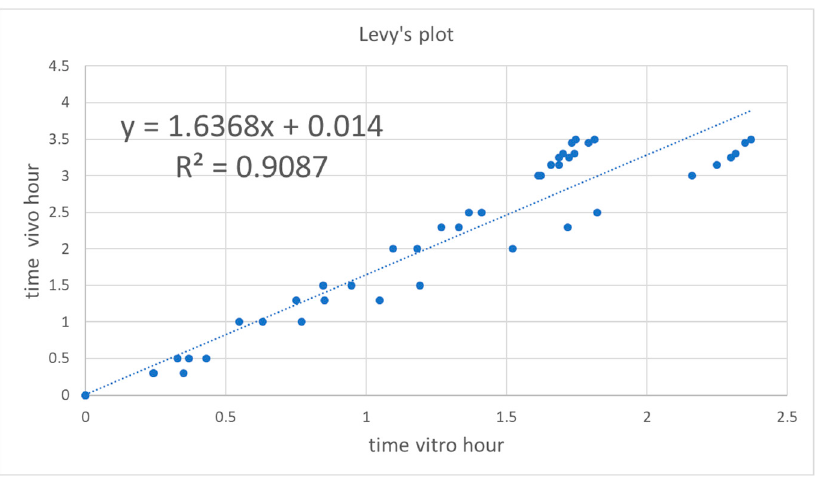
Figure 7. Levy’s plot for Reference, Test 1, Test 2, and Test 3. The plot was constructed using data up to 3.5 h, as at later points the correlation was not a single function. In vitro times were transformed into their equivalent in vivo times and the Weibull function was fitted again to the dissolved fractions at the corrected times.